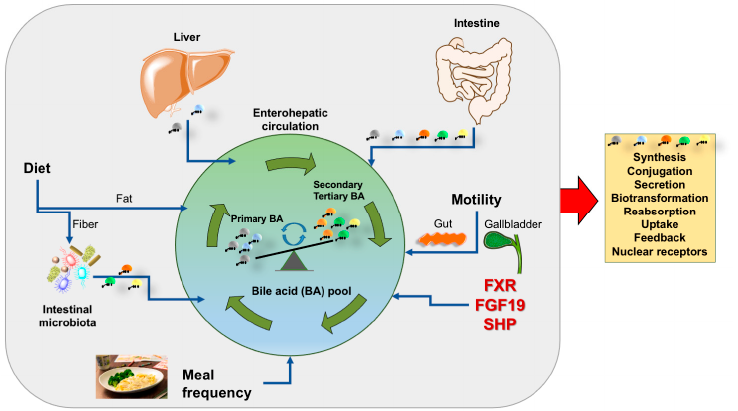
Figure 1. Summary of key factors involved in the composition of the bile acid pool. Several dynamic events are active daily either in the fasting and postprandial period (grey area) and contribute to shape the qualitative/quantitative profile of the bile acid pool, its maintenance and expansion. Such events work in concert with bile acid synthesis and related steps (orange box). Abbreviations: FGF- 19, fibroblast growth factor 19; FXR, farnesoid X receptor; SHP, small heterodimer partner; primary bile acids are cholic and chenodeoxycholic acid (grey); secondary bile acids are deoxycholic acid (orange) and lithocholic acid (green); tertiary bile acid is ursodeoxycholic acid (yellow). The effect of BA works in concert with the activation of the nuclear receptor FXR. This step, in turn, controls BA synthesis, excretion, and reabsorption. These pathways minimize over-accumulation of potentially toxic BA in the liver. Activation of FXR also brings several metabolic effects by regulating lipid metabolism, reducing hepatic gluco- neogenesis, glycolysis, and increasing glycogen synthesis. In parallel, FXR activation has anti- inflammatory properties during liver injury. The FXR-FGF15/19 axis increases en- ergy expenditure and glycogen synthesis and decreases gluconeogenesis and fatty acid synthesis (Figure 2). FXR and FGF19 have become promising targets for the treatment of NASH. Further studies are required in this important field.